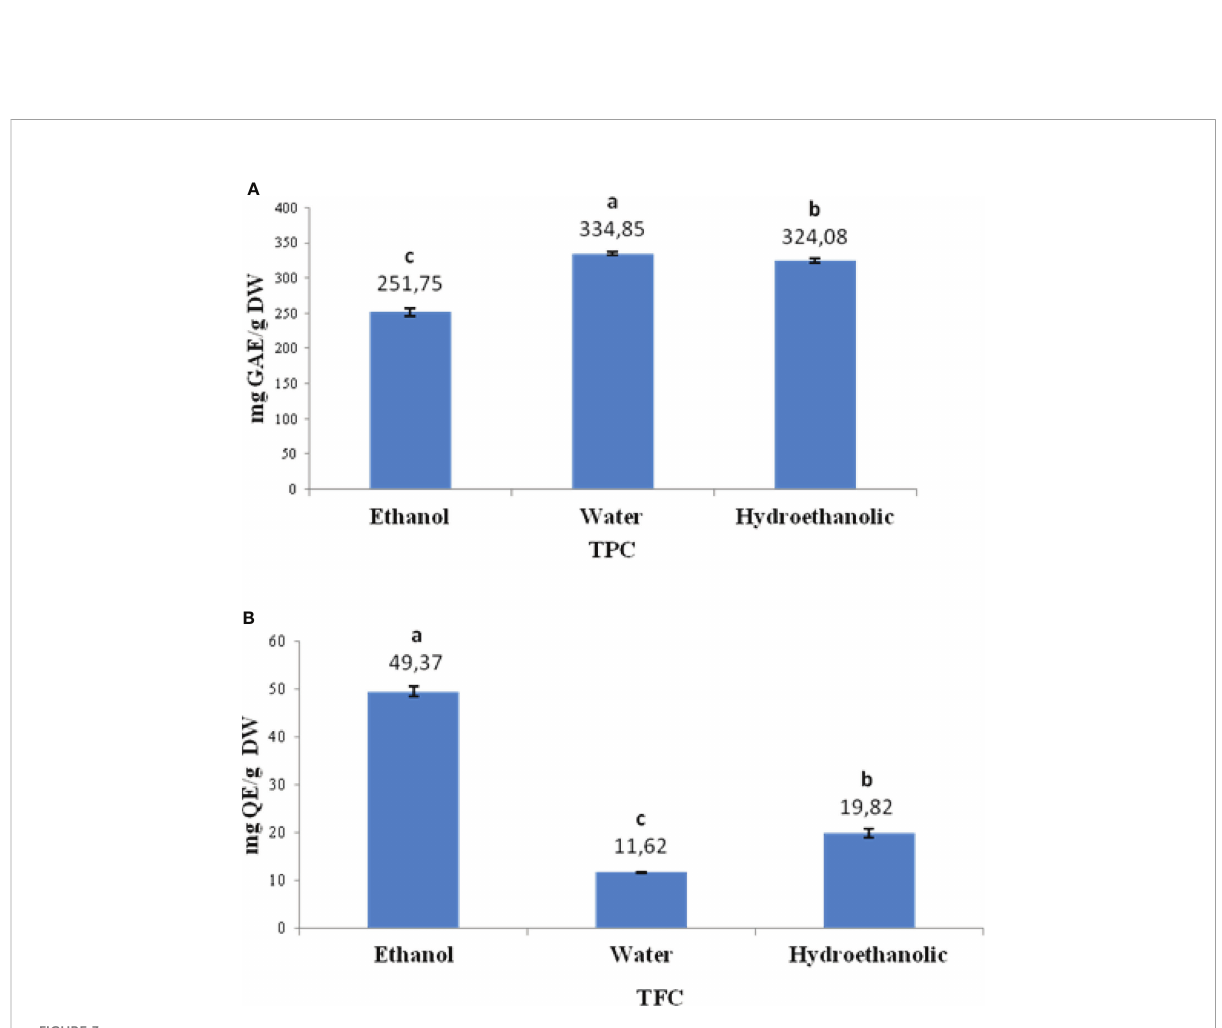
FIGURE 3 Total levels of phenolics (TPC) (A) and fl avonoids (TFC) (B) of ethanol, water and hydroethanolic extracts of Limonium spathulatum . Values represent the mean ± standard deviation (SD) of at least six repetitions (n = 6), expressed as equivalents GAE/g for TPC and QE/g for TFC, DW For each group of compounds, bars marked with different letters are signi fi cantly different at p < 0.05 (Tukey HSD